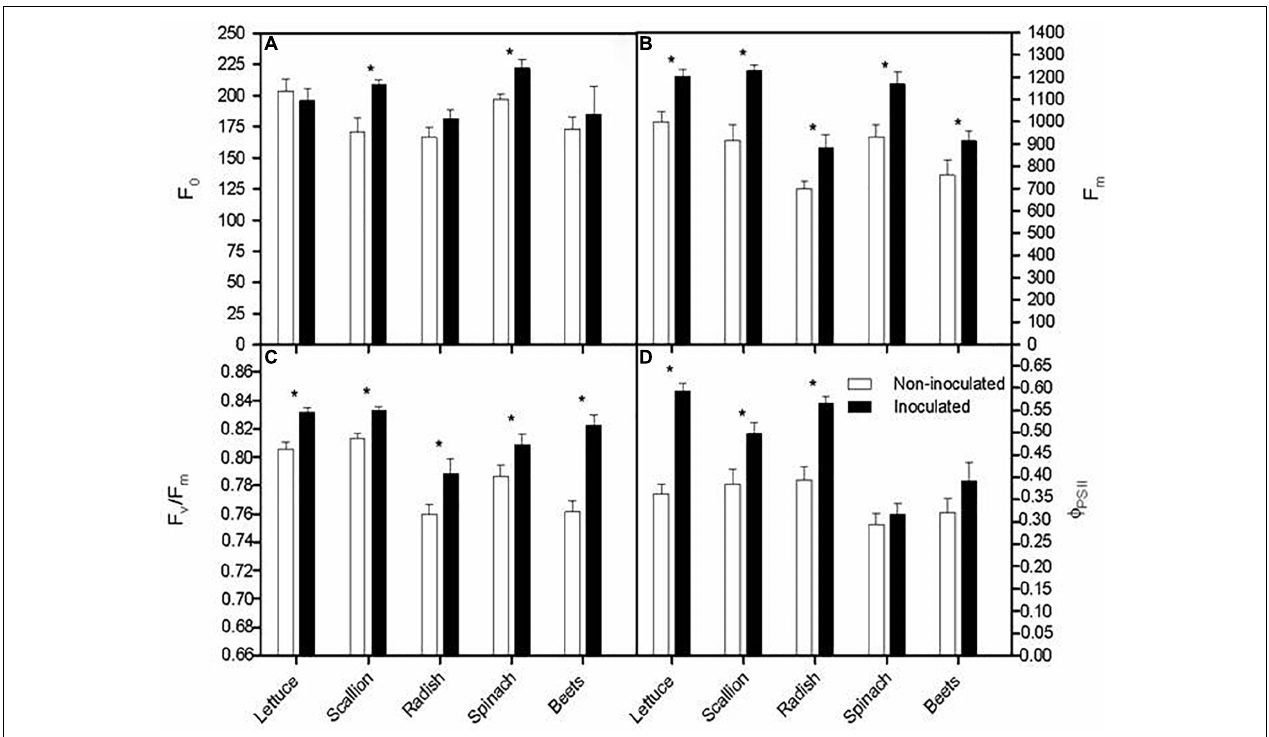
FIGURE 4 | Minimal fluorescence level, F0 (A) , maximal fluorescence level, Fm (B) ; maximum quantum efficiency of PSII photochemistry, Fv/Fm (C) and quantum efficiency of PSII, (cid:56) PSII (D) at midday in randomly selected, fully developed leaves of five winter vegetables in non-inoculated and inoculated plants. Asterisks indicate means that are significantly different between inoculation treatments ( t -test, P <